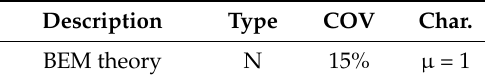
Table 3. Epistemic uncertainties from [16].